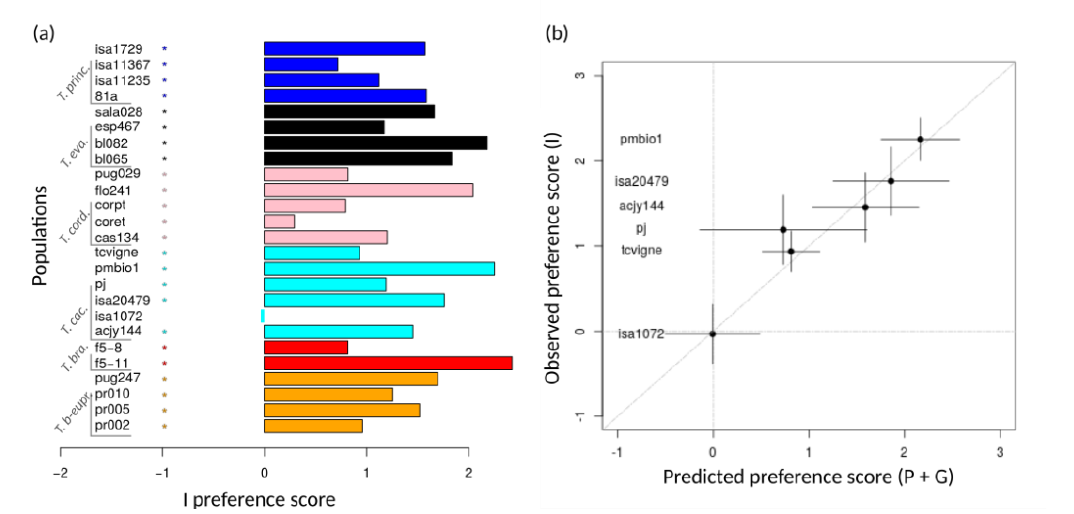
Figure 4. Interactions of photo- and geo- tactic oviposition preferences. (a) “I” preference scores for all 25 populations. Values significantly different from zero after correction for multiple tests are marked